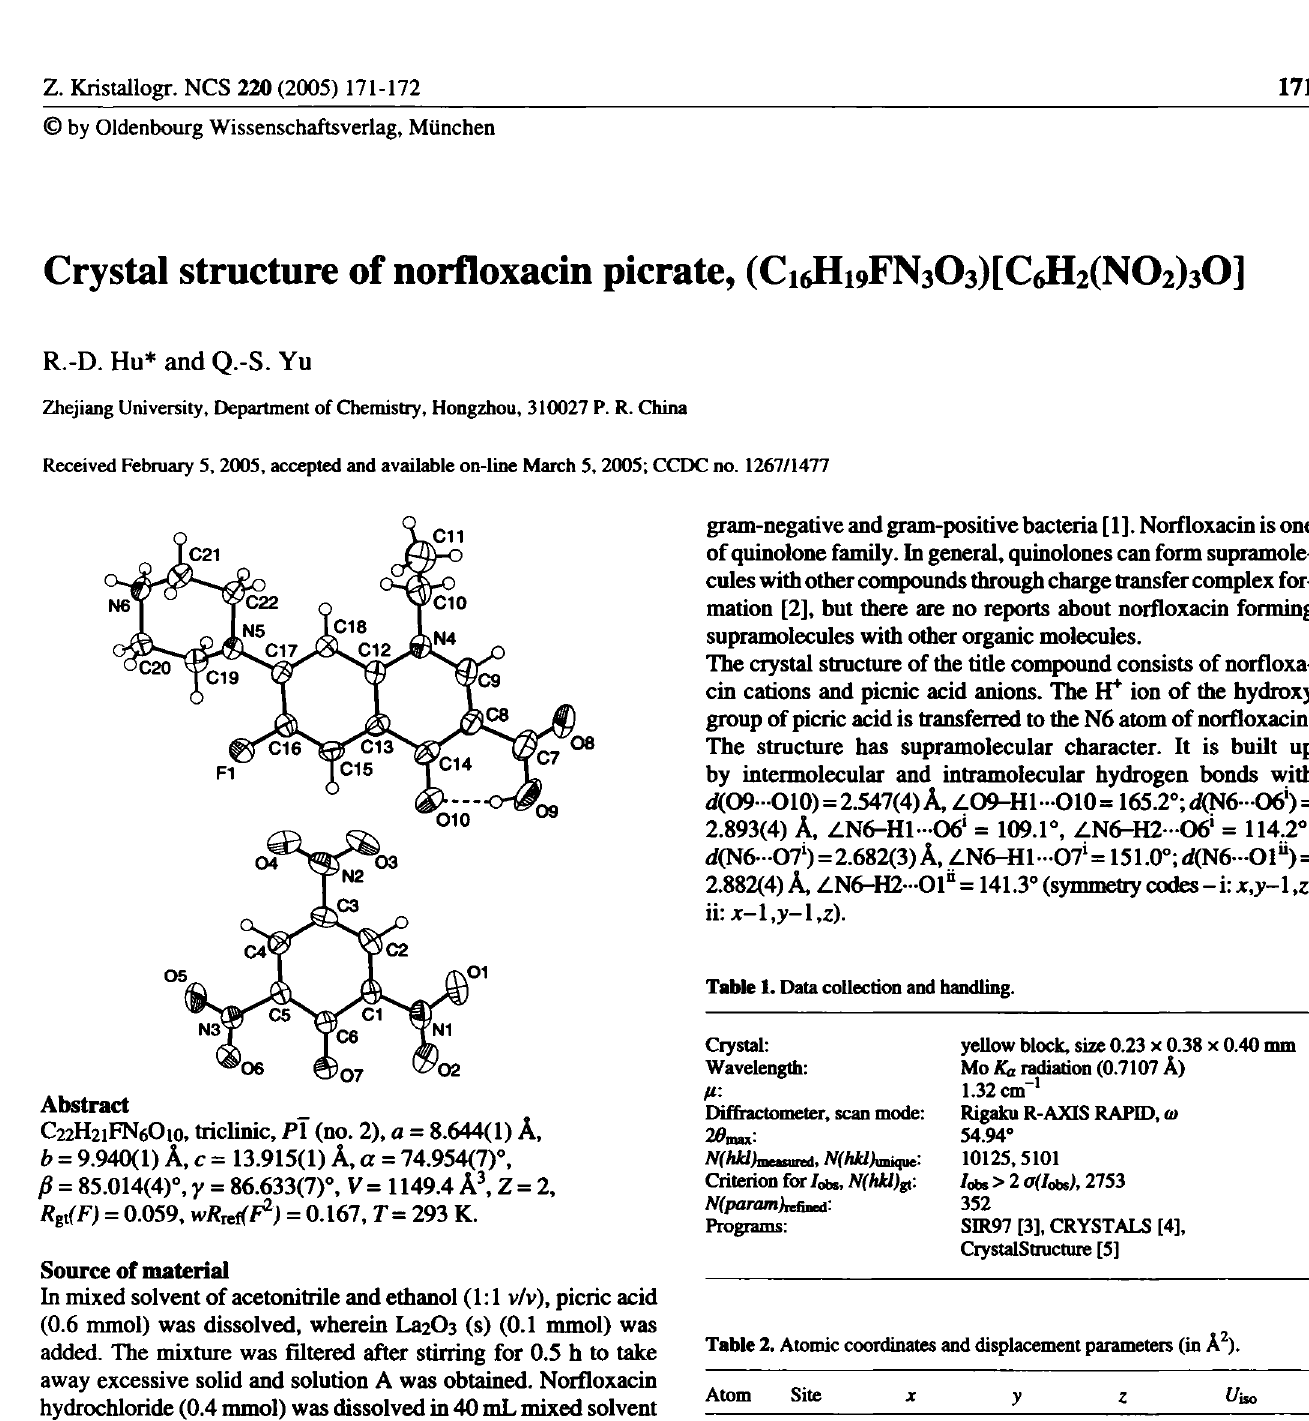
Table 2. Atomic coordinates and displacement parameters (in Ä 2